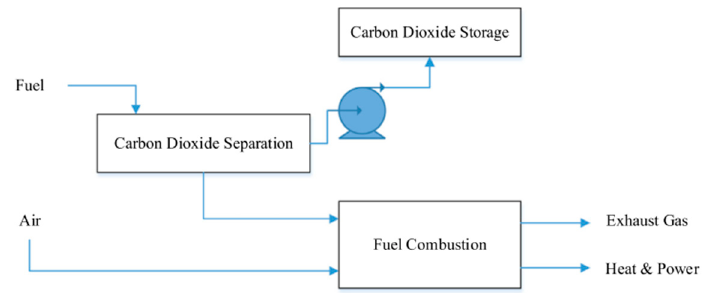
Figure 1. Schematic diagram of the pre combustion carbon capture process [10].